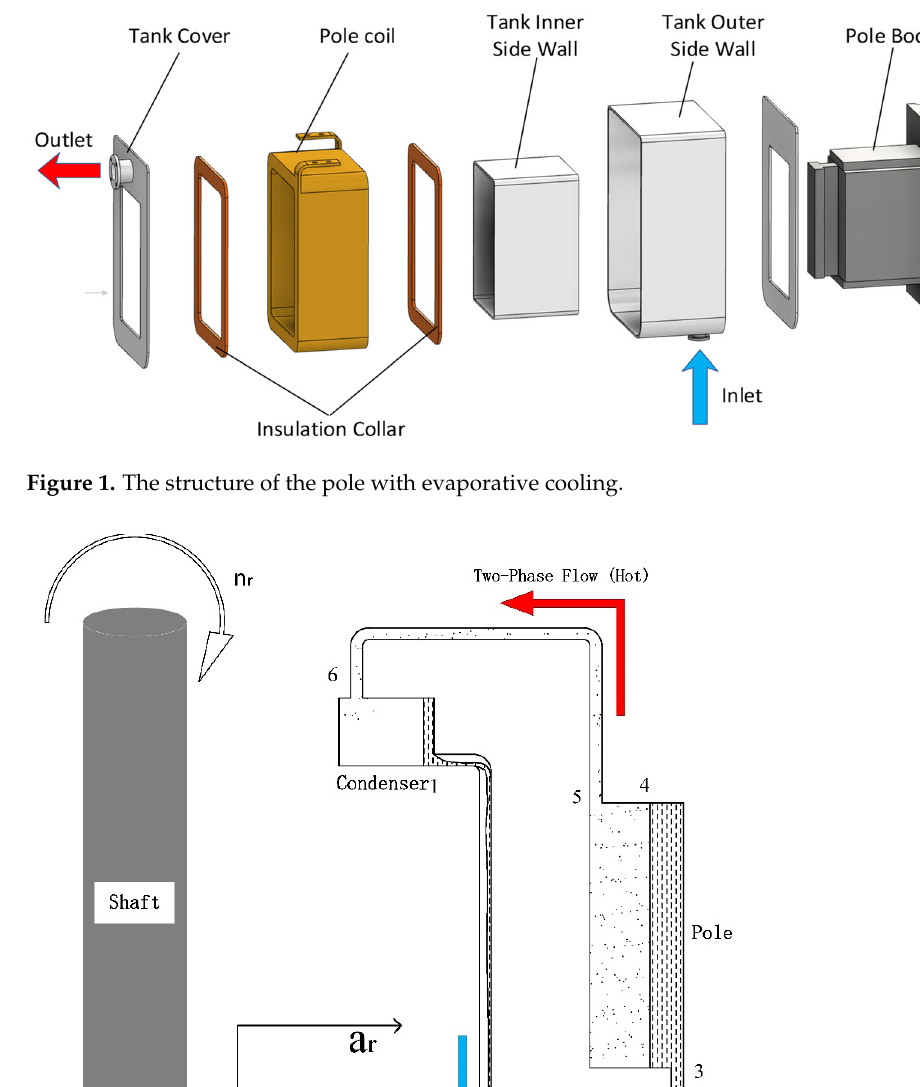
Figure 1. T he structure of the pole with evaporative cooling.